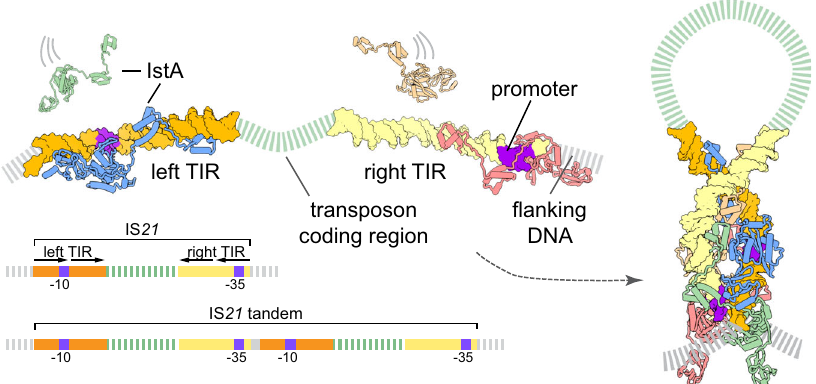
Fig. 8 | Model for IstA assembly and donor DNA recognition. Proposed assembly model for how IstA binding regulates the expression of the IS 21 operon by masking promoter elements in the donor transposon